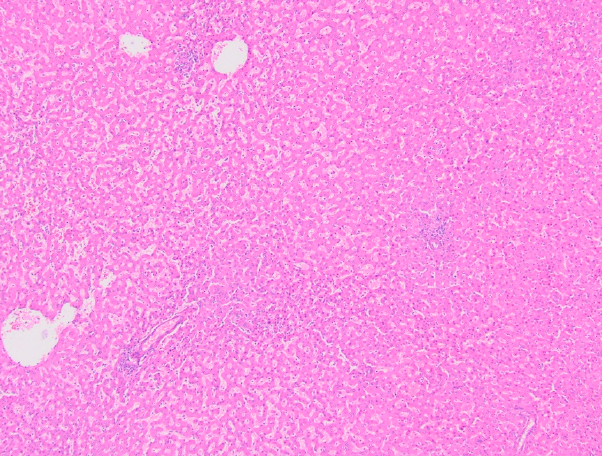
Figure 8. Hepatic adenoma (H&E, 4× magnification). Hepatic parenchyma with no cytologic atypia and effacement of normal lobular architecture, with lack of portal tracts. Table 3. Hepatocellular Adenomas (HCA): Histology, Immunohistochemistry, and Genetic Muta- tions. Histology